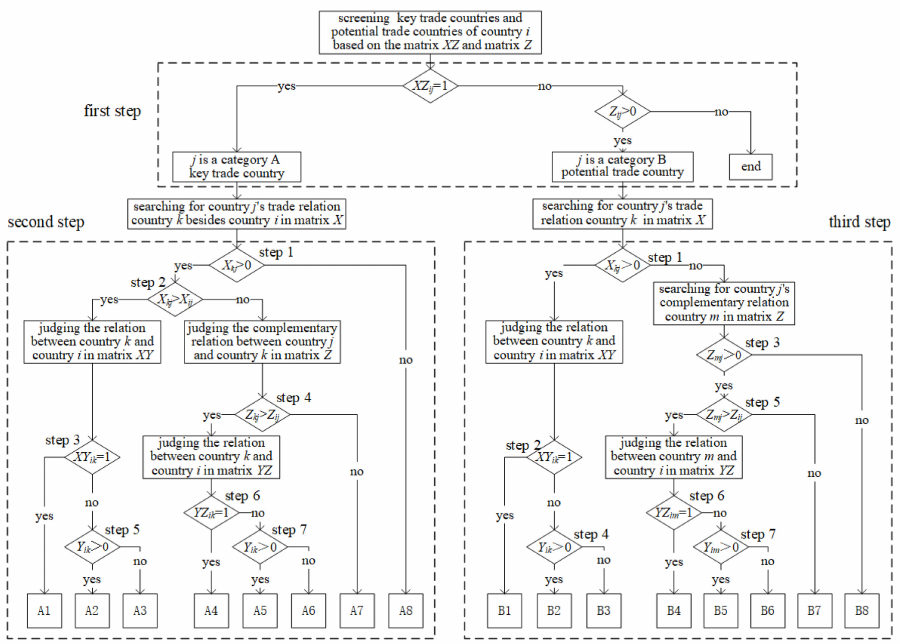
Figure 4. Algorithm analytical flow of the multilayer network of trade relations.